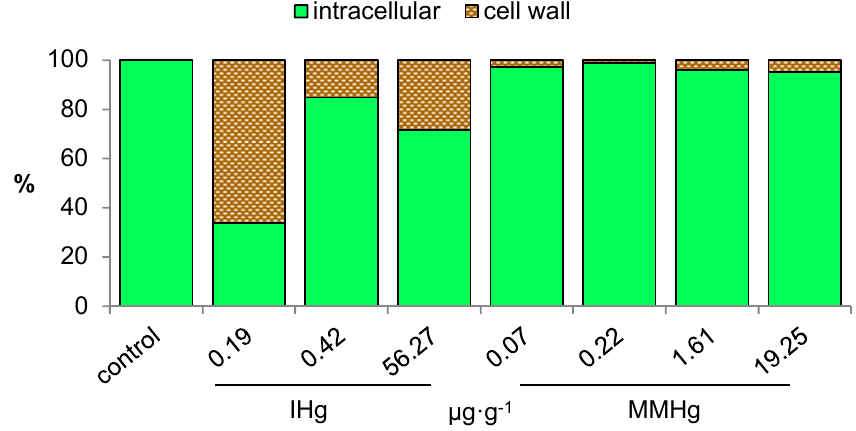
Figure 1. Distribution (%) of THg at the subcellular level in E. nuttallii exposed 2 h to IHg or MMHg in water without DOM [25].